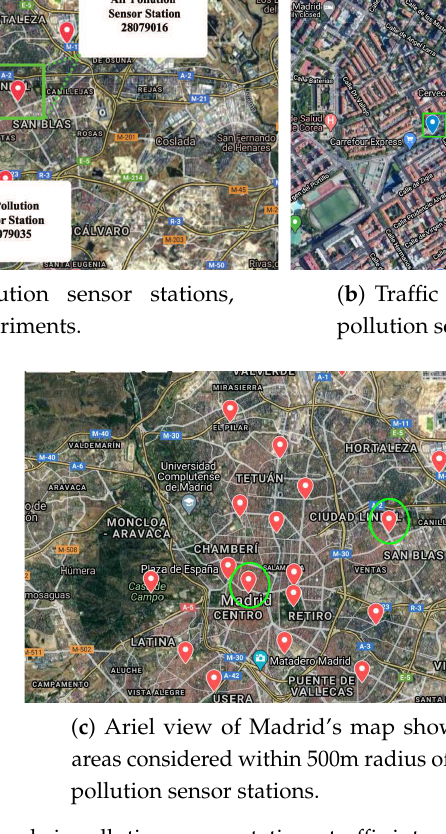
Figure 4. Considered air pollution sensor stations, traffic intensity sensors, and areas in